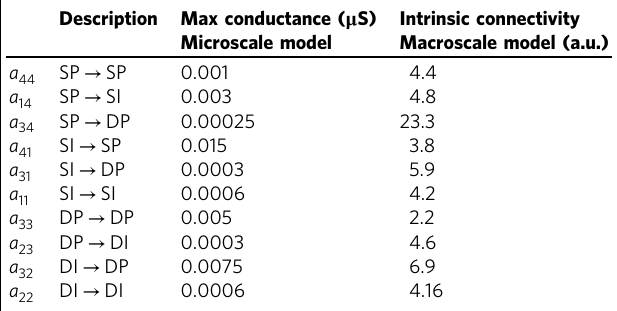
layers, SI; pyramidal cells in super fi cial layers, SP; inhibitory interneurons in deep layers, DI; pyramidal cells in deep layers, DP. Each parameter corresponds to one arrow. There are in total ten connections in both the microscale and macroscale models.